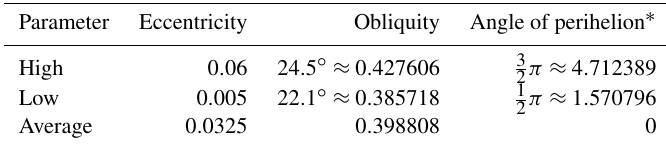
Table 3. Orbital parameter extremes used to examine the maximal influence that the parameters have on the modeled distributions of insola- tion and temperature as shown in Fig. 5. To examine the effect of one parameter, the other two were set to average values and an equilibrium simulation with land, sea, and ice configuration as in Fig. 1 and constant CO 2 = 315ppm and S 0 = 1362Wm − 2 was run.